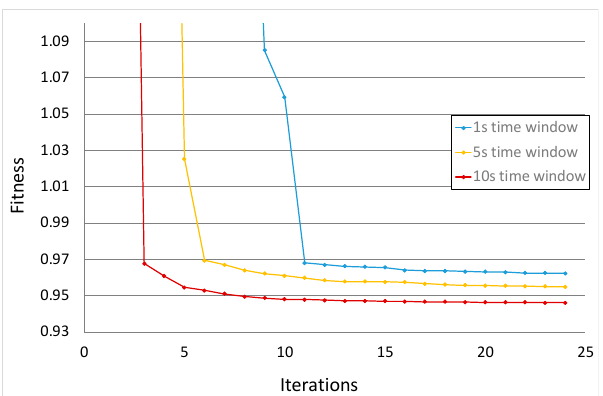
Figure 7. Evolution of the mean value of the fitness of the best solution found by the DE algorithm in the feasible region for the case of one intermediate timing point.